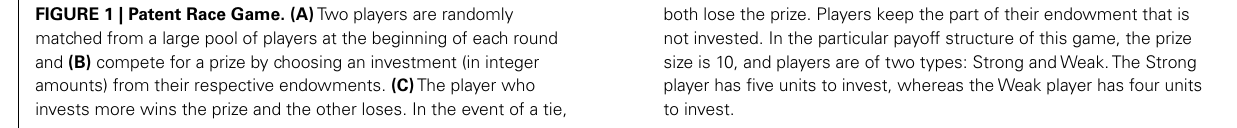
both lose the prize. Players keep the part of their endowment that is not invested. In the particular payoff structure of this game, the prize size is 10, and players are of two types: Strong andWeak.The Strong player has five units to invest, whereas theWeak player has four units to